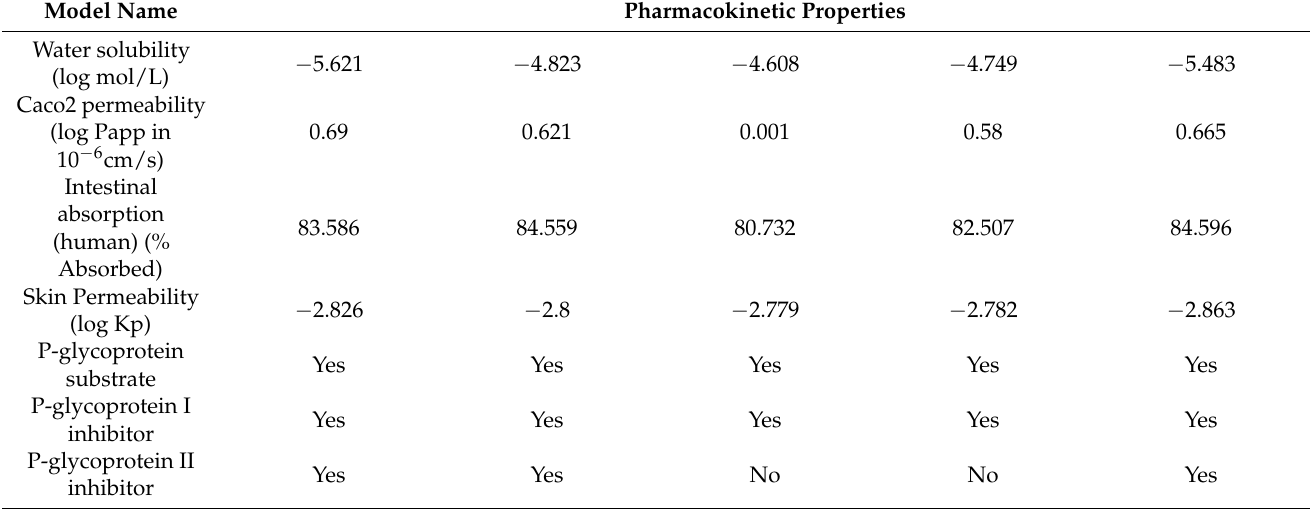
Table 10. Pharmacokinetic properties.